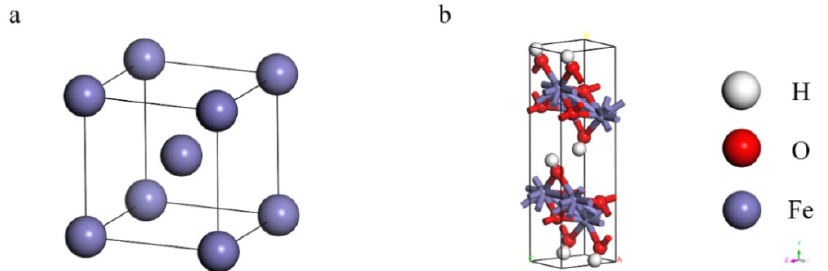
Figure 1. Crystal structures: ( a ) Fe and ( b ) γ -FeOOH.